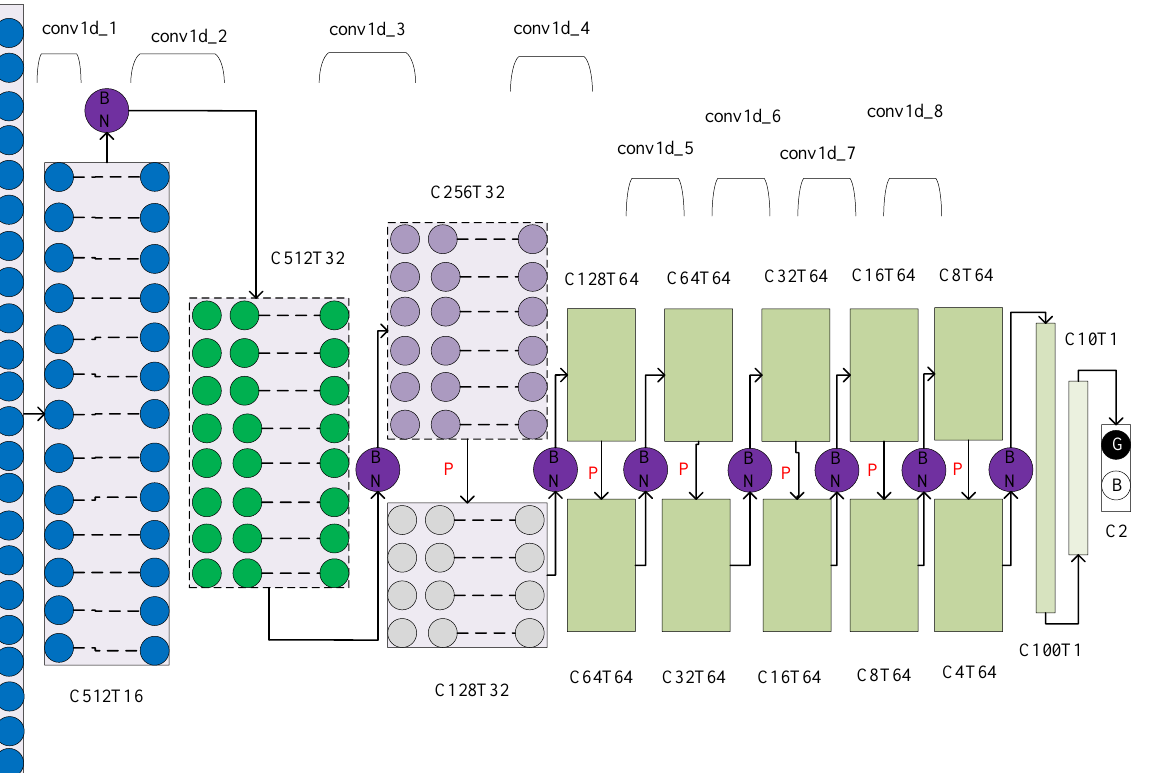
Figure 3. The structure of ITICNN.